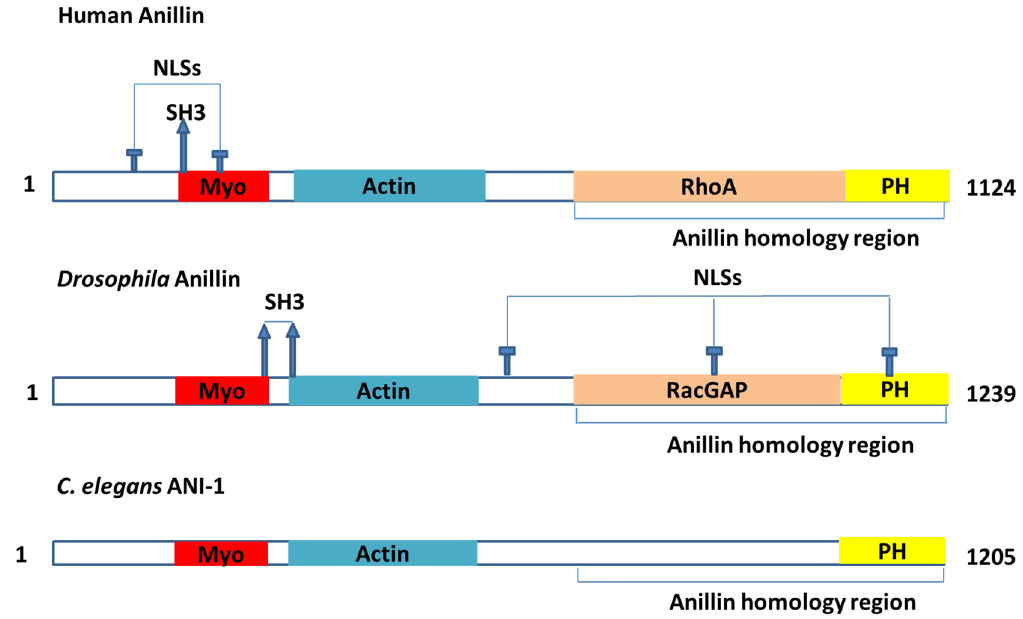
Figure 1. The model of the major domains in the ANLN actin-binding protein. My, myosin-II-binding domain; Actin, actin-binding domain; NLS, nuclear localization signal; PH, pleckstrin homology domain; RacGAP, region that interacts with the RacGAP50C component of the centralspindlin complex; RhoA, region that interacts with the GTPase RhoA; SH3, Src-homology-3-binding consensus sequences. Table 1. The roles and characteristics of ANLN and its partners in cytokinesis.